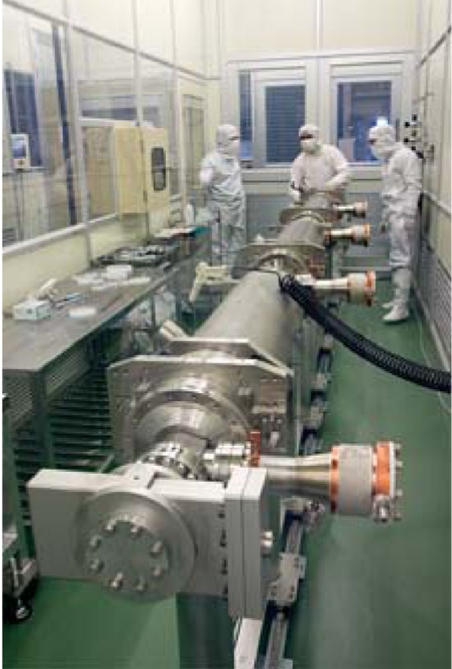
FIG. 7. (Color) Cavity string assembly in class-10 clean